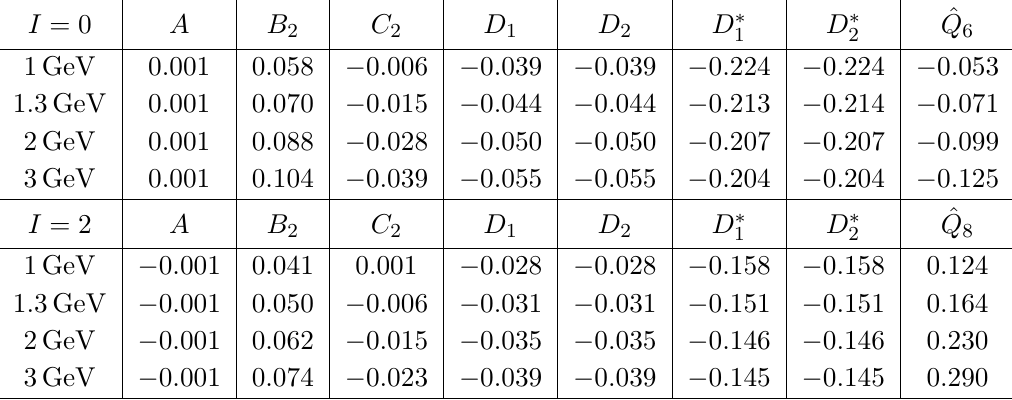
signi(cid:12)cantly with increasing (cid:22) . An exception is the operator Q SLL ;u